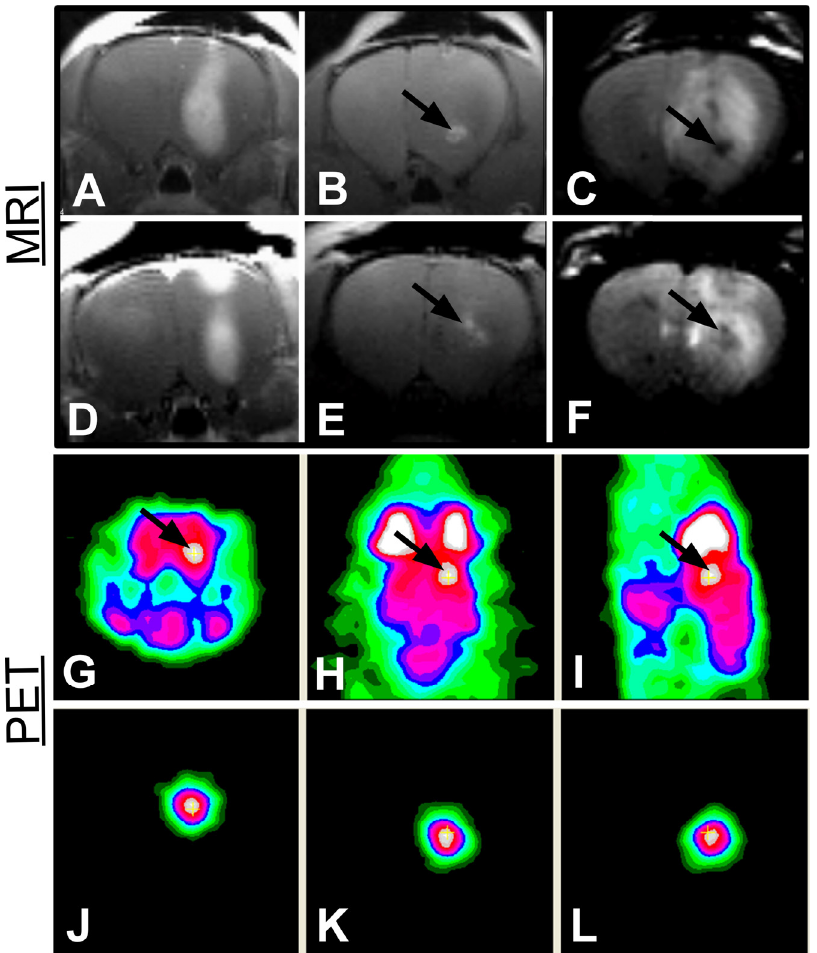
Figure 6. Magnetic resonance (MR) images from two representative orthotopic tumor bearing rat brains and microPET images from one representative rat infused with the ( B , E ) T -weighted images showing bright contrast at the infusion site due to the 1 124 I-f-Gd N@C . ( C , F ) T -weighted images with dark contrast due to the 3 80 2 ( G ) Coronal, ( H ) axial, and ( I ) sagittal microPET images following 18 F-FDG injection with the additive image signal allowing for localization of the 124 I-f-Gd hemisphere of the rat brain (arrows point to infusion